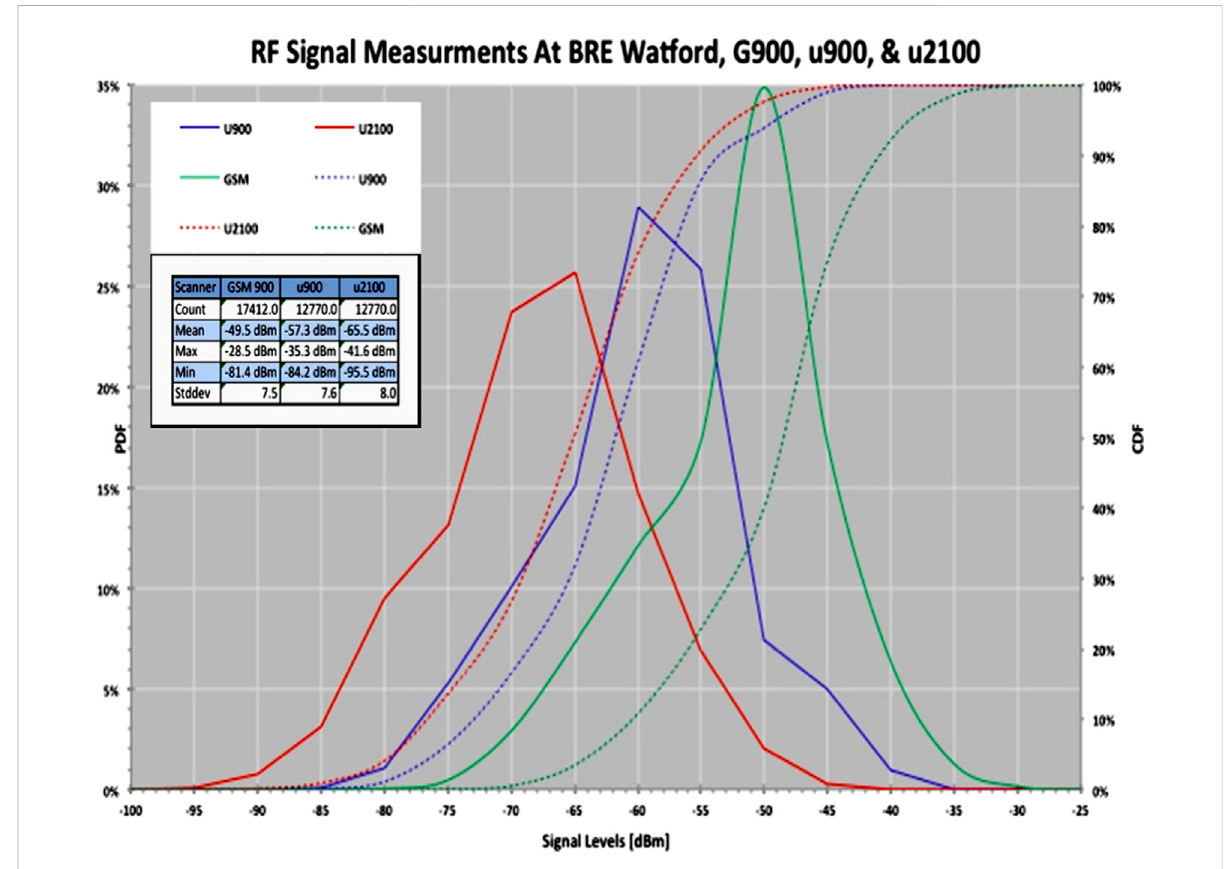
FIGURE 2 Statistical Distribution of the Measurements made at the BRE.